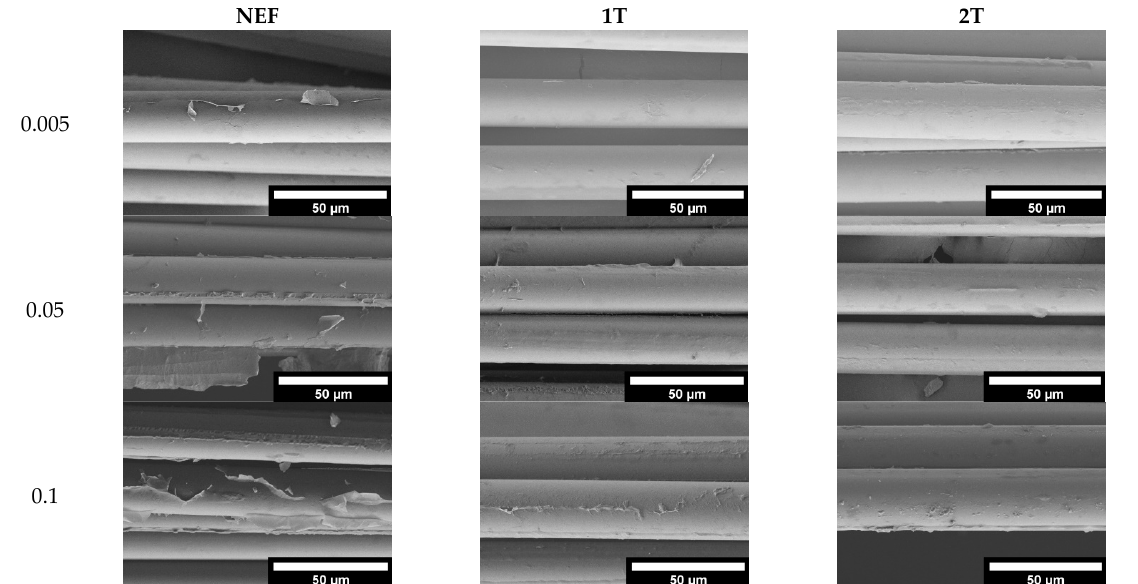
Figure 7. SEM images of rGO coated samples with varying graphene oxide (GO) concentrations and electrification process. Representative load–displacement curves obtained from microdebonding tests on